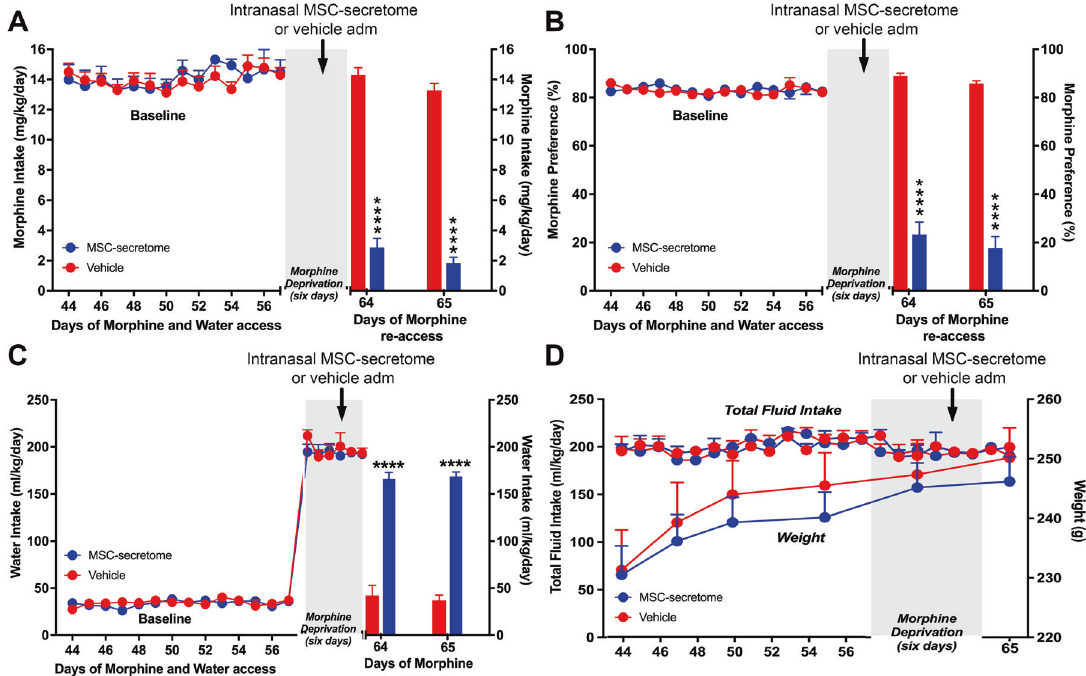
Fig. 6 A single intranasal administration of secretome derived from human preconditioned MSCs during the deprivation period to UChB rats that had chronically consumed morphine markedly reduces post-deprivation relapse. A Morphine relapse intake and ( B ) Morphine preference over water of UChB rats that had voluntarily consumed morphine for 57 days were morphine deprived for six days and intranasally treated with a single dose of secretome derived from preconditioned MSCs or vehicle (indicated by the arrow) on day 61. Relapse morphine intake and morphine preference upon re-access to the 80 and 90 mg/l morphine solutions over water was signi fi cantly reduced in secretome treated rats (80% to 85% **** p < 0.0001, two-tailed Student t test) on the two re-access days (blue bars in A and B ) compared with vehicle treated animals (red bars in A and B ). C Daily water intake showing that secretome administration during the morphine deprivation period signi fi cantly increased water intake (days 64 and 65) (**** p < 0.0001, Two-tailed Student t test) upon morphine re-access (blue bar) compared with vehicle-treated animals (red bar). D Total fl uid intake and animals body weight of UChB rats intranasally treated with secretome derived from preconditioned MSCs (blue circles) or vehicle (red circles) during the deprivation period. Data shows that these parameters were not affected by secretome administration. Data are presented as mean ± SEM; n = 6 for each experimental